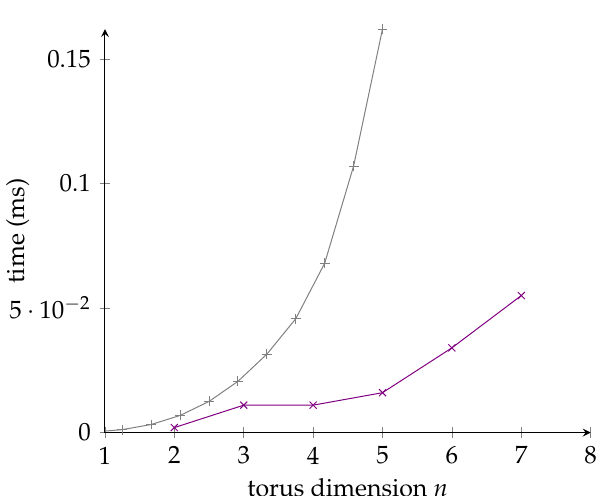
Figure 9. Empirical evaluation: average execution time to solve one problem instance with the proposed algorithm in a T ( n ,max { 5, n + 1 } )